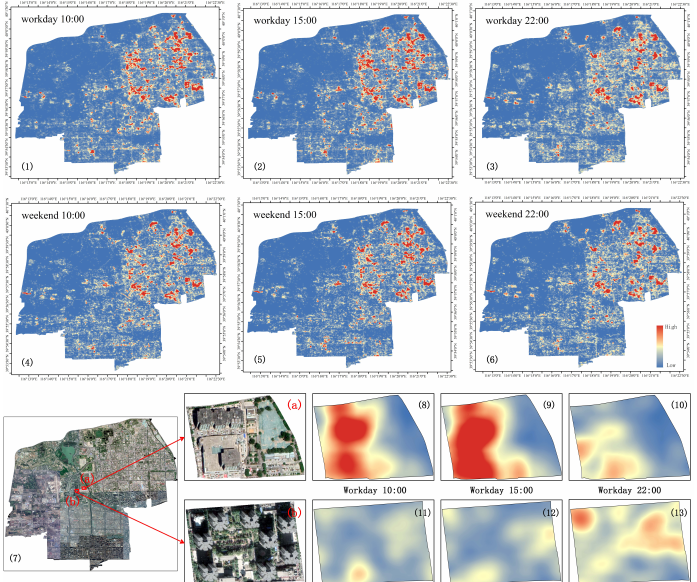
Figure 5. The density of human activities in the study area. ( 1 – 6 ) show the distribution of human activity density at three typical moments in the whole study area. ( 7 ) shows the locations of a typical commercial zone ( a ) and a typical residential zone ( b ). ( 8 – 13 ) are the enlarged details of human activity density of ( a , b